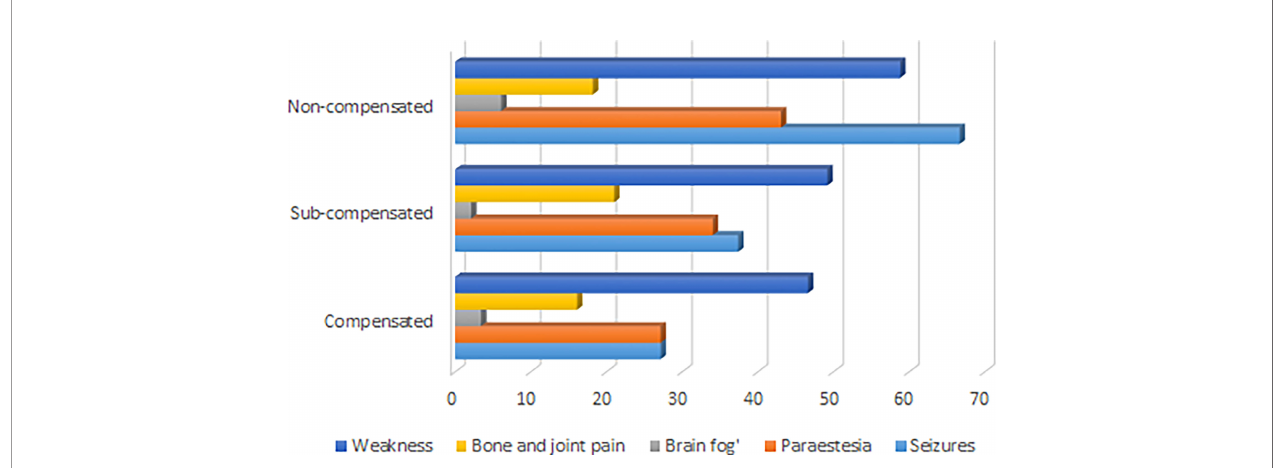
FIGURE 1 | Symptoms of hypoparathyroidism according to degree of compensation of disease.